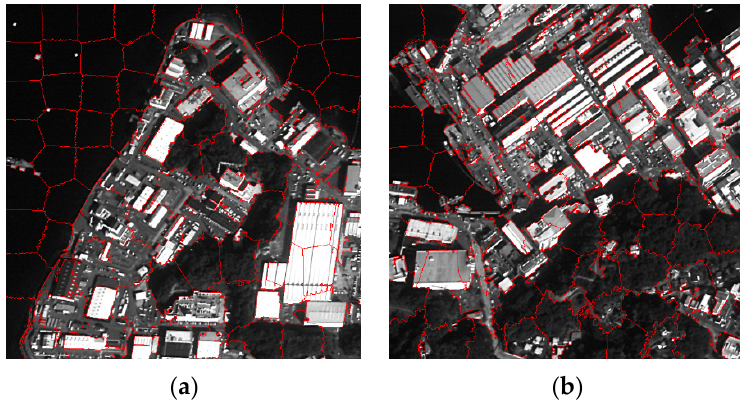
Figure 4. The flowchart of saliency model for building detection.